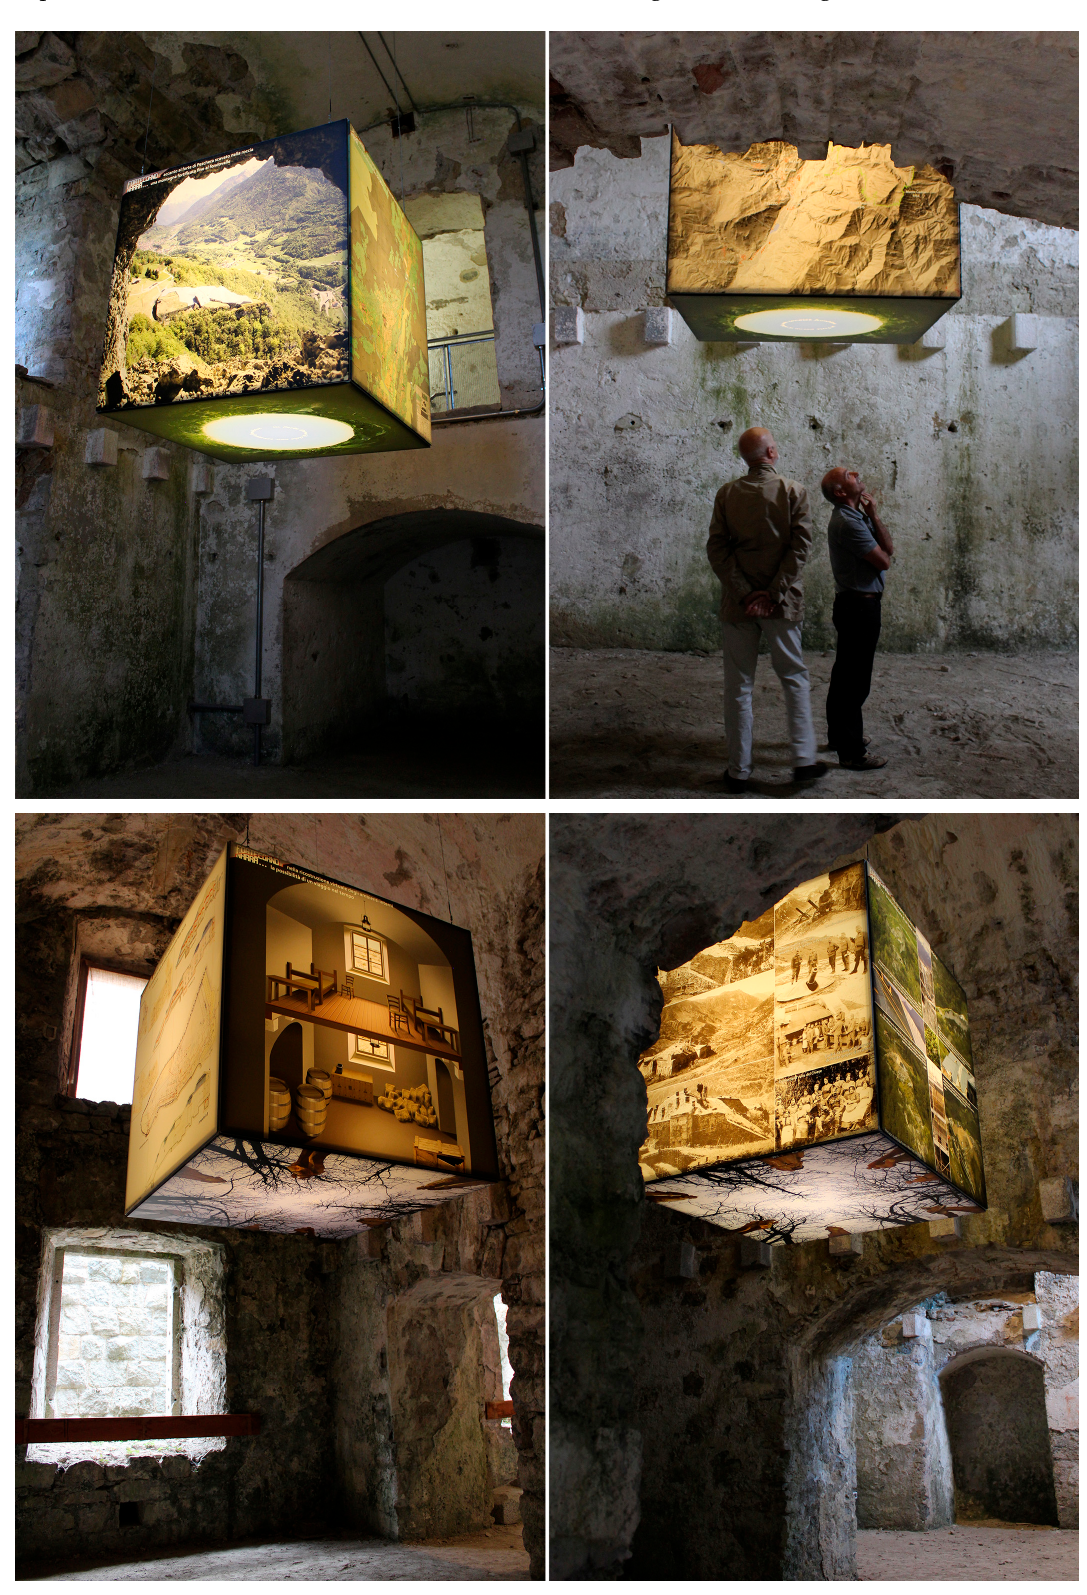
Figure 3. The exhibition design in the interiors of Forte